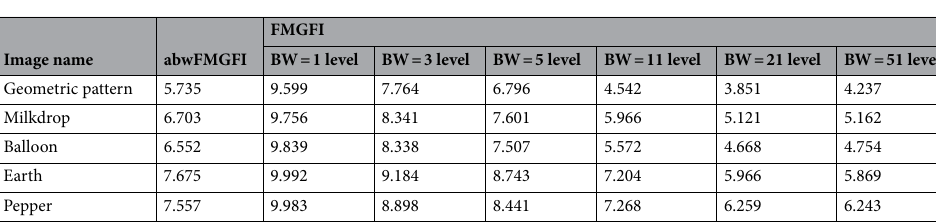
Table 9. Comparison of the RMSE values of each sample image filtered using the variable level of BW of FMGFI (against the Gaussian noise).